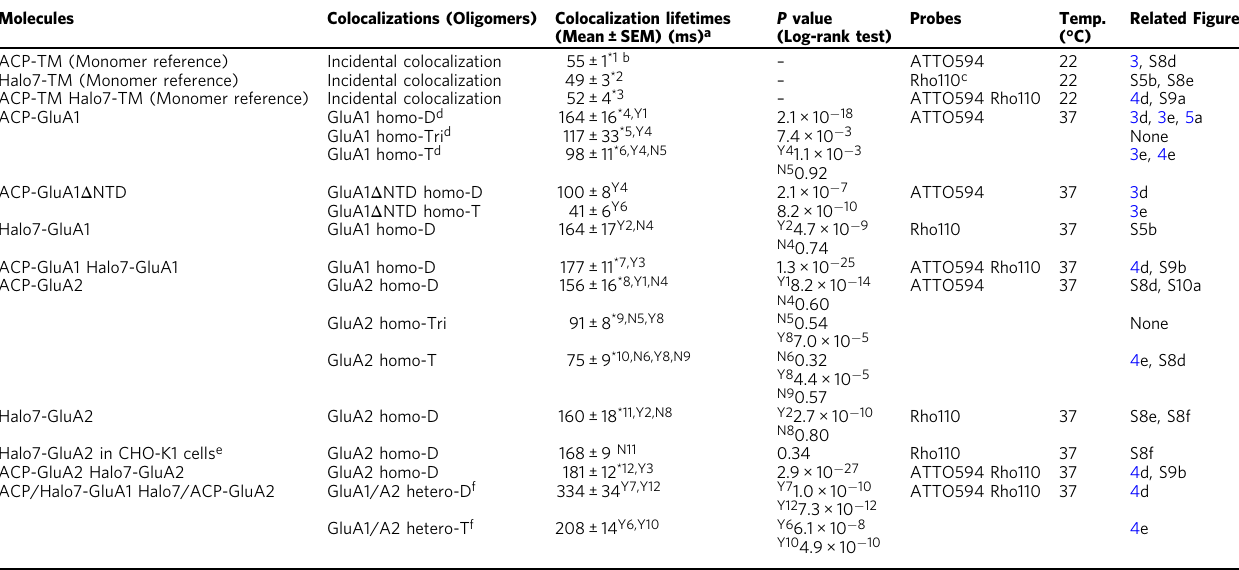
Table 1 Summary of colocalization durations of fl uorescently-labeled, tagged molecules of GluA1, GluA1 Δ NTD, GluA2, and TM in the HEK293-PM